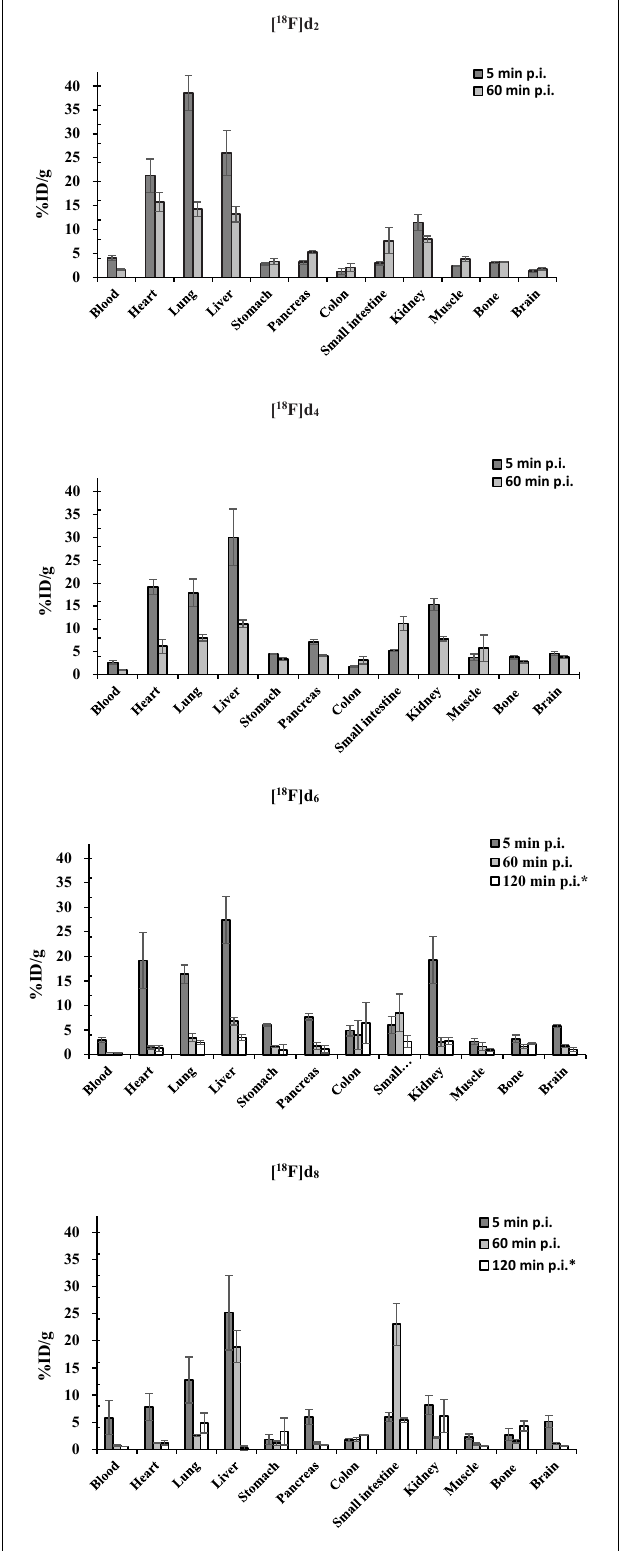
FIGURE 11 | Biodistribution of [ 18 F]d 2 , [ 18 F]d 4 , [ 18 F]d 6 , and [ 18 F]d 8 in healthy C57BL/6J mice (*biodistribution after PET dynamic